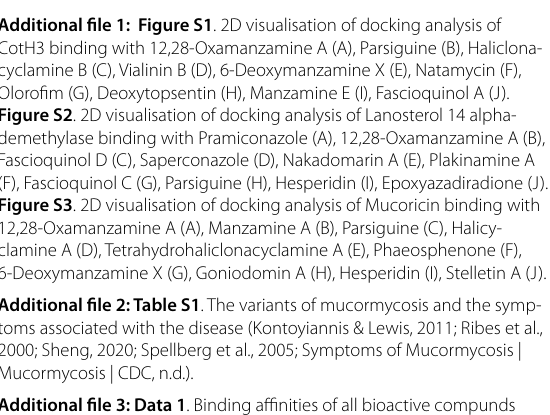
Figure S2 . 2D visualisation of docking analysis of Lanosterol 14 alpha- demethylase binding with Pramiconazole (A), 12,28-Oxamanzamine A (B), Fascioquinol D (C), Saperconazole (D), Nakadomarin A (E), Plakinamine A (F), Fascioquinol C (G), Parsiguine (H), Hesperidin (I), Epoxyazadiradione (J). Figure S3 . 2D visualisation of docking analysis of Mucoricin binding with 12,28-Oxamanzamine A (A), Manzamine A (B), Parsiguine (C), Halicy- clamine A (D), Tetrahydrohaliclonacyclamine A (E), Phaeosphenone (F), 6-Deoxymanzamine X (G), Goniodomin A (H), Hesperidin (I), Stelletin A